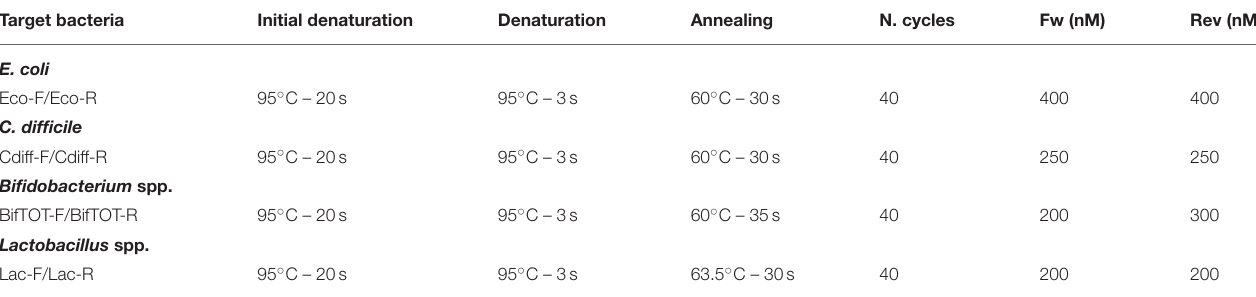
TABLE 2 | qPCR amplification protocols and primer